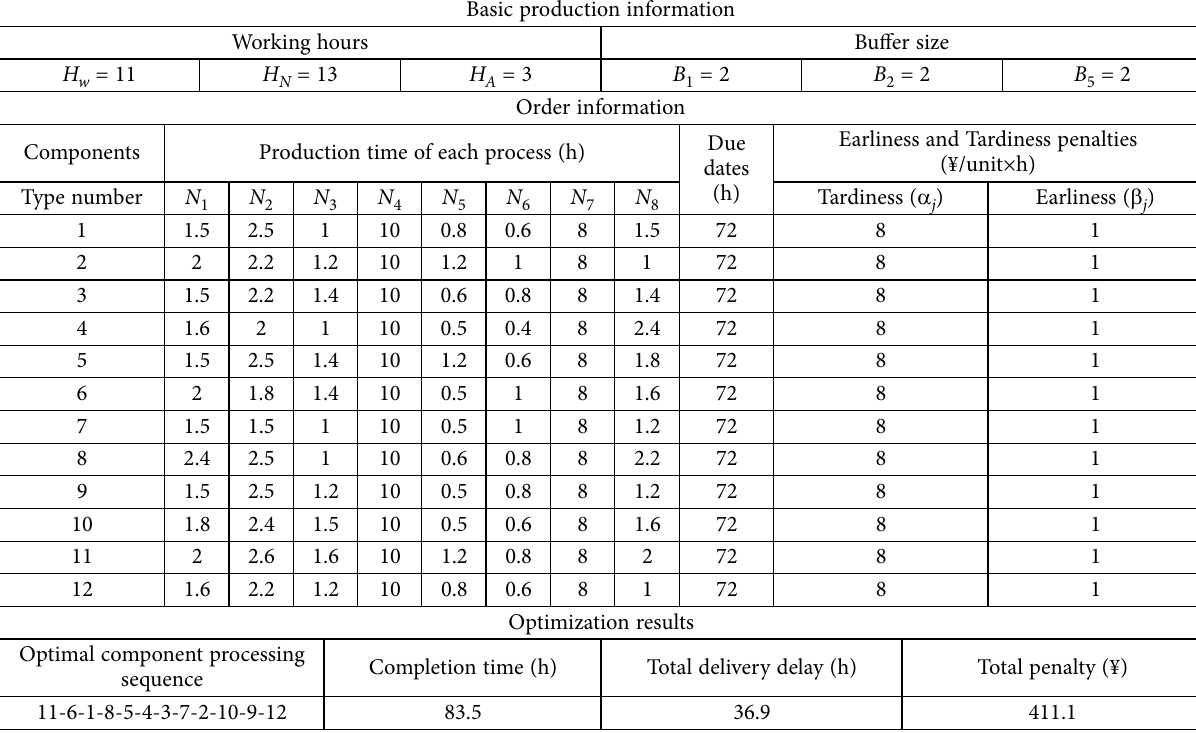
Table 8. Input data and optimization results of the 12-component